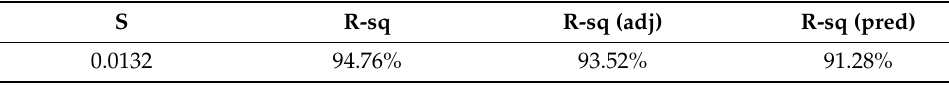
Table 6. Model summary of regression analysis for